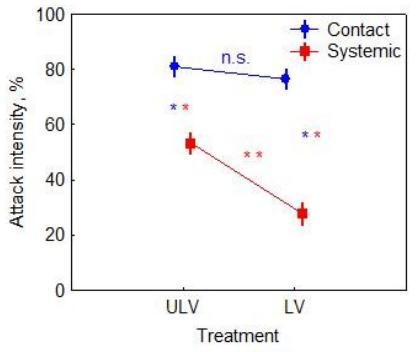
Figure 7. Effects of applied insecticide type (contact vs. systemic) on nymph density by leaf position (lower canopy vs. upper canopy) at each measurement time: ( a ) M0 (before spraying)-24 June 2020; ( b ) M1-09 July 2020; ( c ) M2-16 July 2020; ( d ) M3-24 July 2020; ( e ) M4-29 July 2020; and ( f ) M5-05 August 2020. ** = significant differences (U test, p < 0.05); n.s. = nonsignificant.